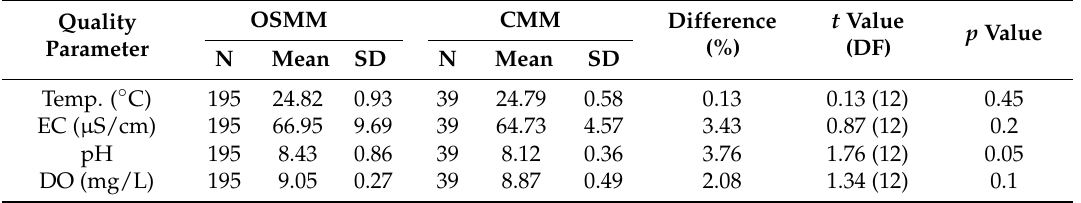
Figure 6. ( a ) Electrical conductivity (EC) and ( b ) temperature measurements, as made by the OSMM and CMM. Table 3. Descriptive statistics for water quality parameters obtained by the OSMM and CMM, after applying correction factors to the EC and temperature